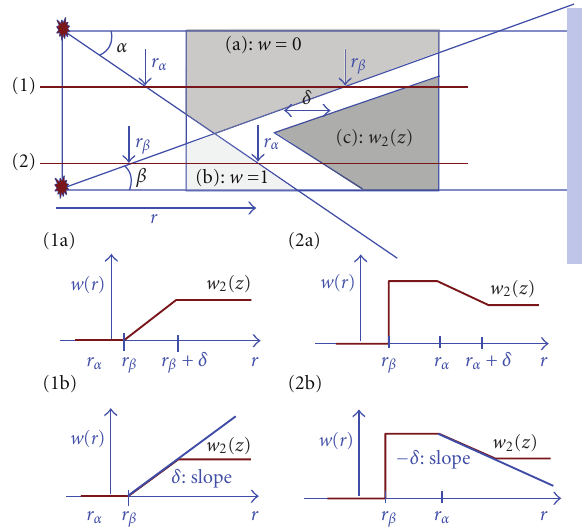
Figure 9: The top picture represents a longitudinal view of the proposed weighting scheme. Two specific slices are selected: slice (1) includes voxels from region (a) and region (c), and slice (2) includes voxels from region (b) and region (c). The corresponding weight profiles are shown at the bottom: (1a) and (2a) show the fixed feathering width case, where the width is defined as δ ; (1b) and (2b) show the fixed feathering slope case, where the slope is defined as δ